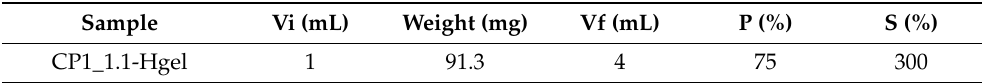
Table 4. Results from swelling